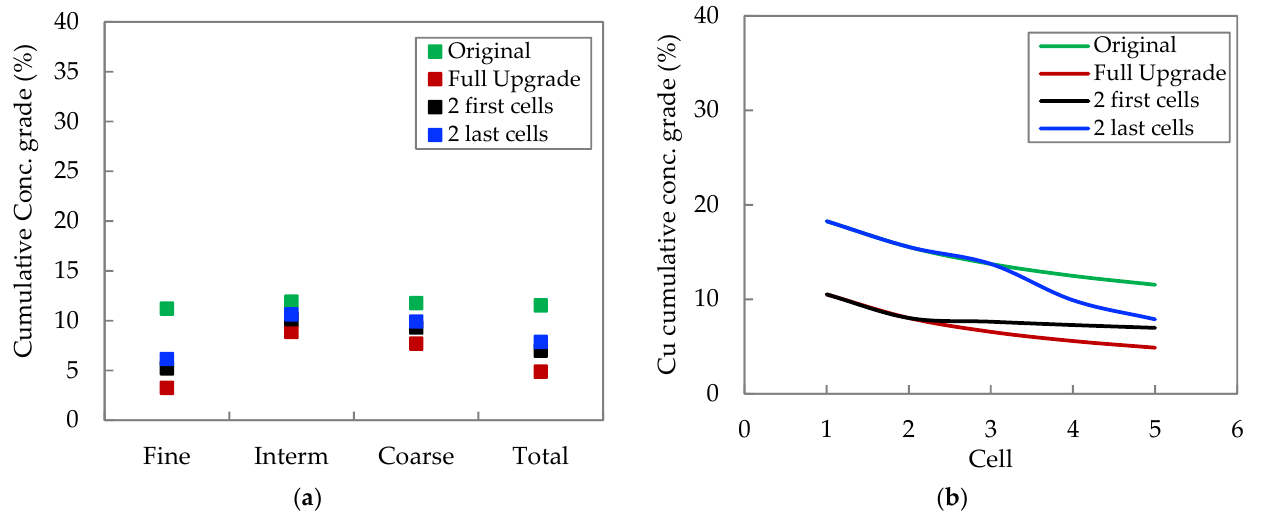
Figure 10. Cu concentrate grade results for the four scenarios: ( a ) Cumulative Cu concentrate grade per particle size class and ( b ) concentrate grade profiles for fine particles ( − 45 µm).